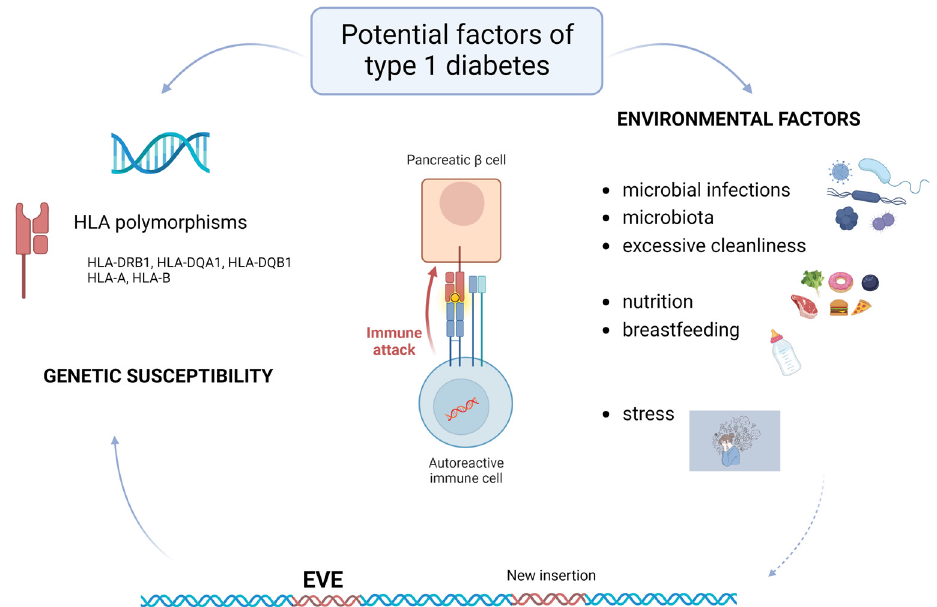
Figure 1. Interplay of factors associated with type 1 diabetes (T1D). Solid arrows indicate established connections, while the dashed arrow indicates a hypothesized connection. HLA—human leukocyte antigen, EVE—endogenous viral element.